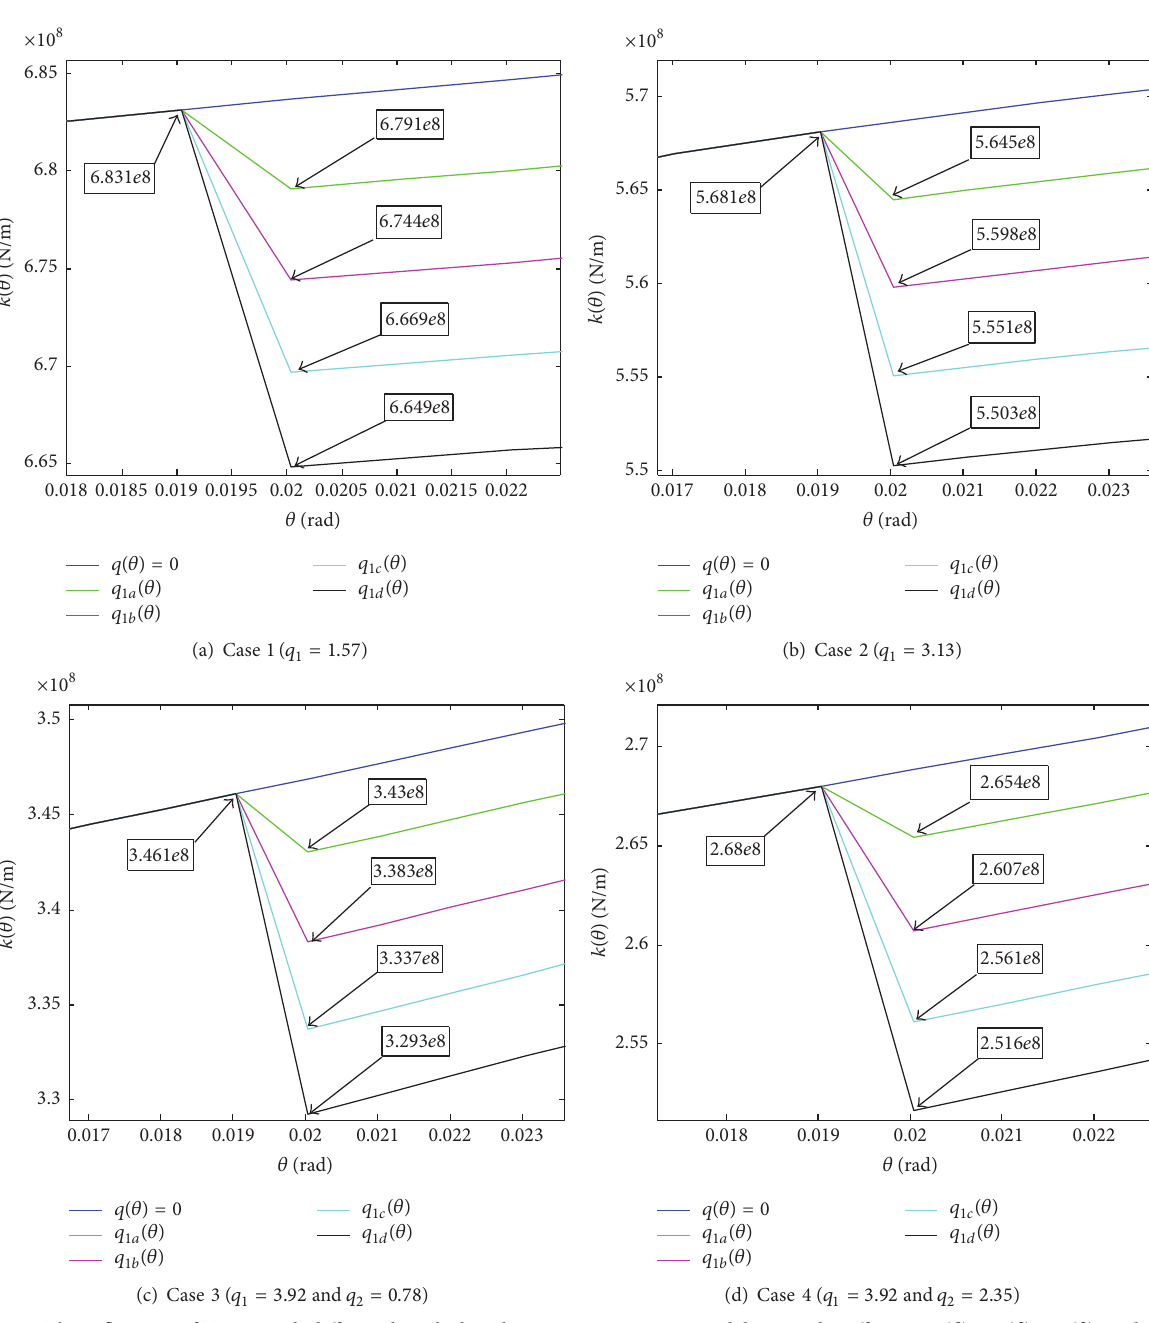
Figure 5: The influences of TPOC with different lengths but the same propagation model on mesh stiffness. 𝑞 1𝑎 (𝜃) , 𝑞 1𝑏 (𝜃) , 𝑞 1𝑐 (𝜃) , and 𝑞 1𝑑 (𝜃) represent the crack propagating with the model of a step function, which indicates that the crack has instantaneously propagated by a tiny length. The corresponding lengths are 0.05, 0.1, 0.15, and 0.2 mm. 𝑞(𝜃) = 0 represents the absence of